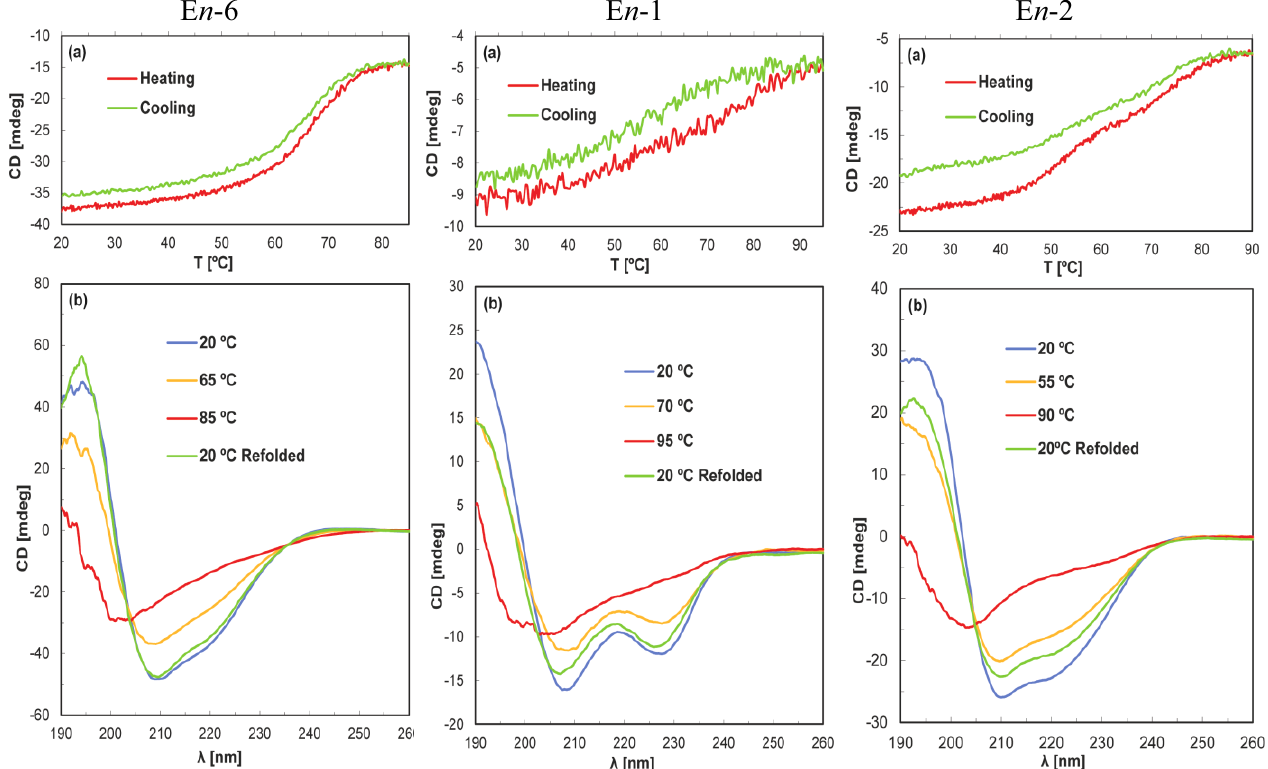
Figure 2. Temperature-induced denaturation of the E. nobilii psychrophilic pheromones E n -6, E n -1 and E n -2 monitored by CD spectroscopy. ( a ) Temperature variation of the signal intensity at 220 nm during heating and cooling over the range from 20 °C to 95 °C. ( b ) CD spectra at different temperatures, as indicated by the color code in the figure. The protein concentration was 20 µM in 20 mM sodium phosphate at pH 6.0, and the cell length 0.1 cm. The temperature variation of the signal intensity at 220 nm in panels ( a ) was recorded at a rate of 1.0 °C/min. Scans were recorded with a speed of 100 nm/min, in 5 °C intervals over the temperature range of panels ( a ); for improved clarity, only four traces are shown in panels ( b ). E n -6 E n -1 E n